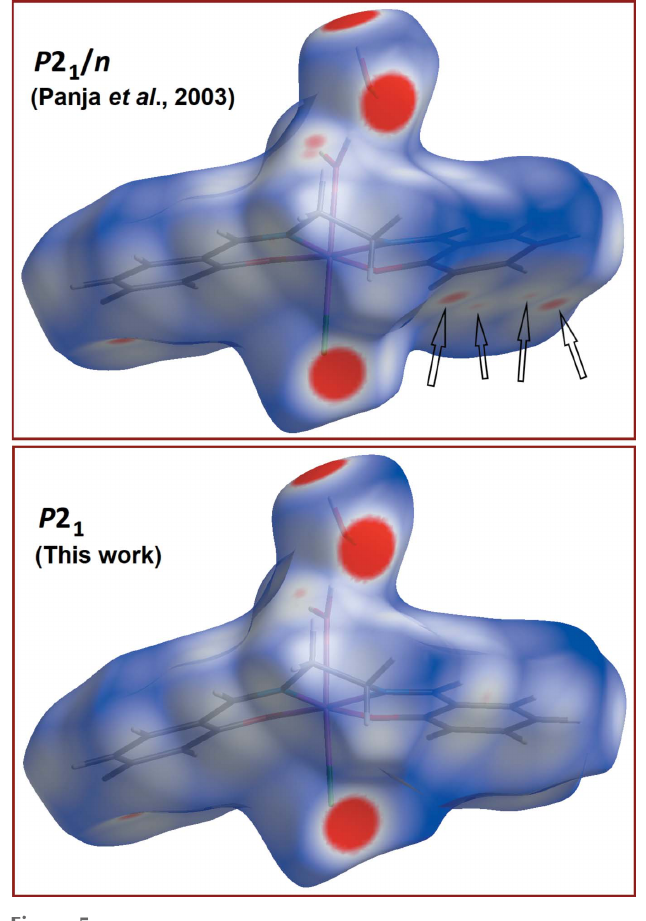
Figure 5 Hirshfeld surfaces mapped over d norm ( (cid:3) 0.15 to 1.20 A˚ ) for the P 2 1 / n polymorph reported in 2003 (Panja et al. , 2003; top) and the novel P 2 1 polymorph (bottom). Arrows in the first case indicate regions where intermolecular distances are shorter than van der Waals contacts, because of (cid:5) – (cid:5) interactions.